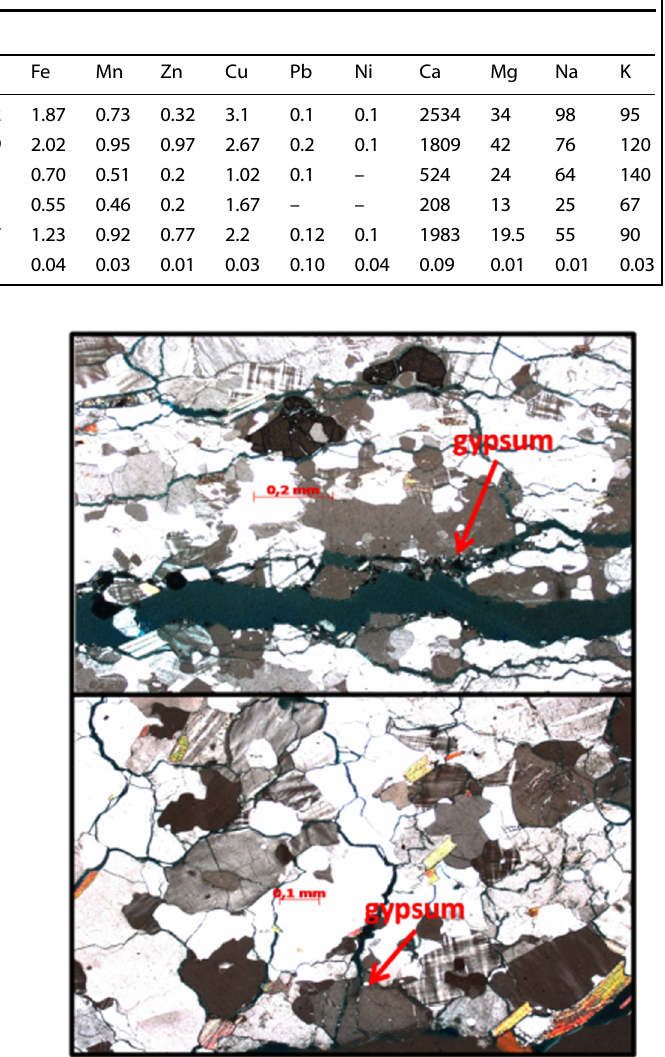
Table 2. Average concentrations (mg.L − 1 ) of the main substances detected in stone samples from the facades of various churches in Rio de Janeiro.